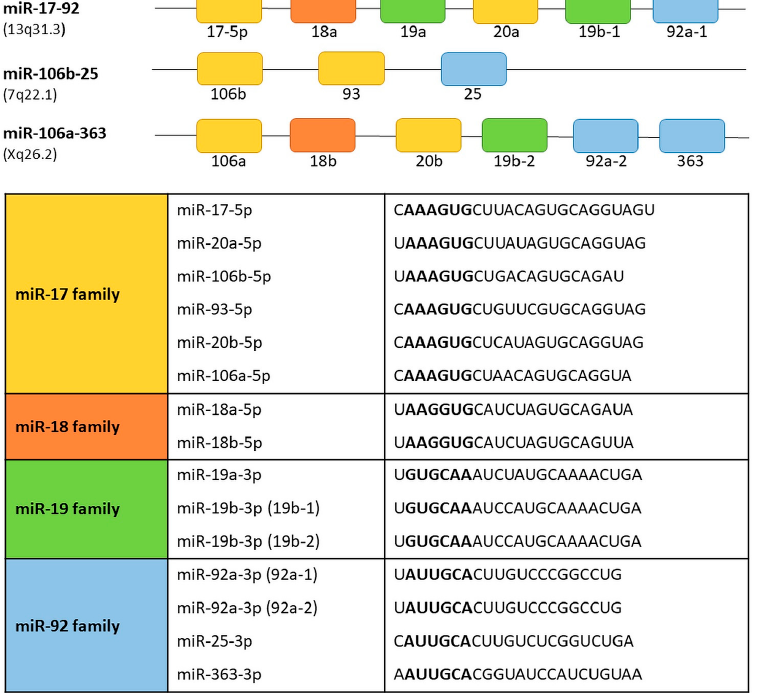
Figure 2. Transcript organization of the human miR-17-92 and its paralogs, miR-106a-363 and miR-106b-25 clusters. miRNAs sharing the same seed sequence are represented by boxes of the same color. The miRNAs are grouped into four seed families. Seed sequences are shown in bold.